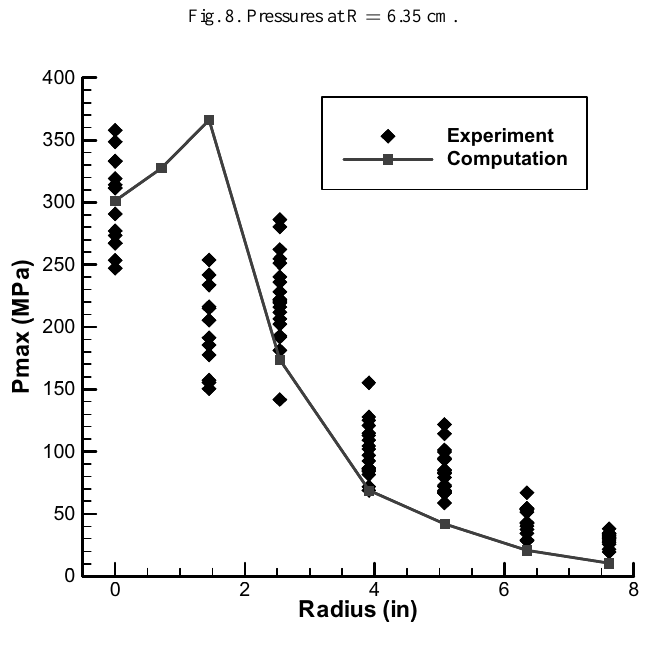
Fig. 8. Pressures at R = 6.35 cm.